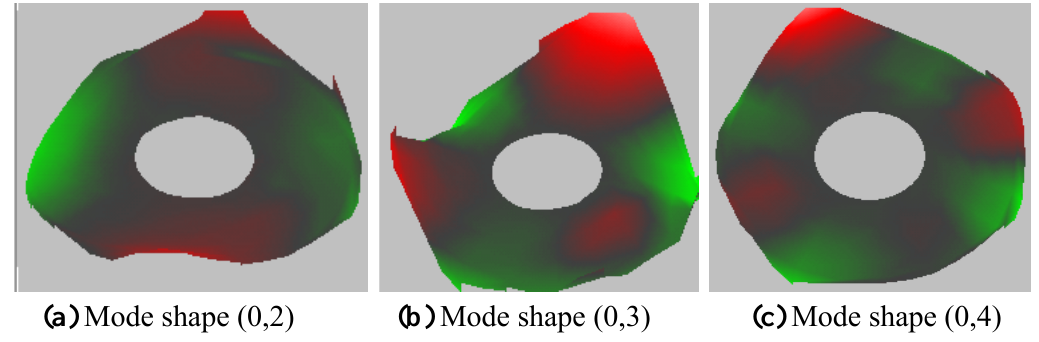
Figure 5. Measured Modeshapes of Modes (0,2), (0,3) and (0,4) of Disk